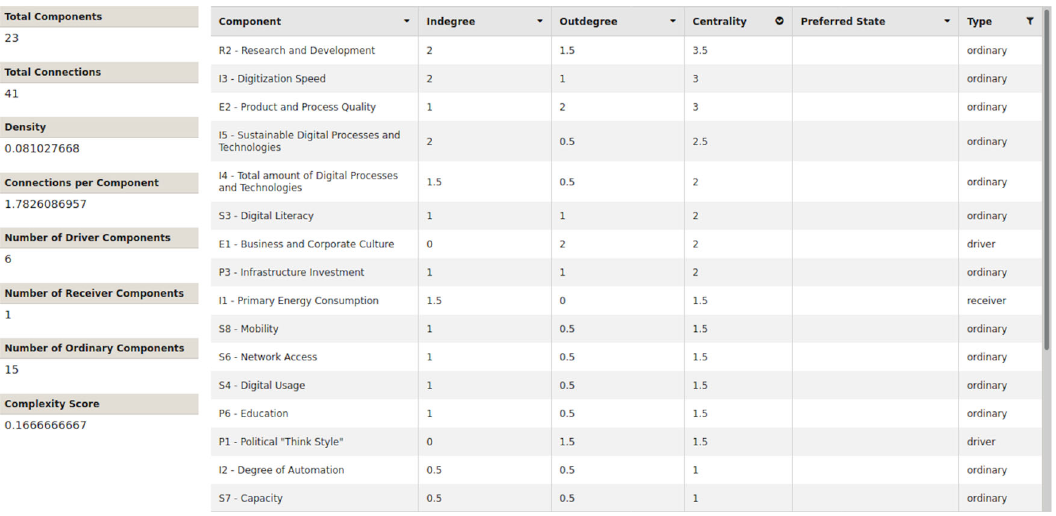
Table 14: All three scenarios differ from each other in the order and evaluation of the centrality parameters.